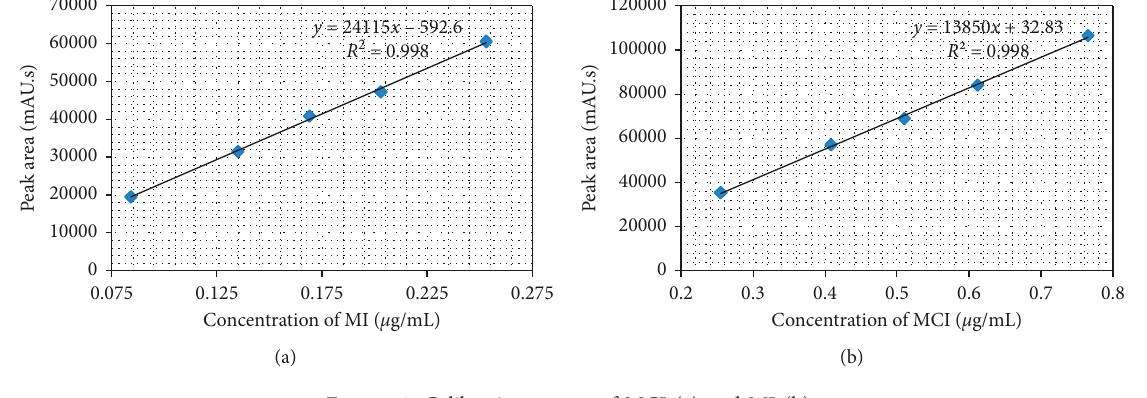
Figure 3: Calibration curves of MCI (a) and MI (b).